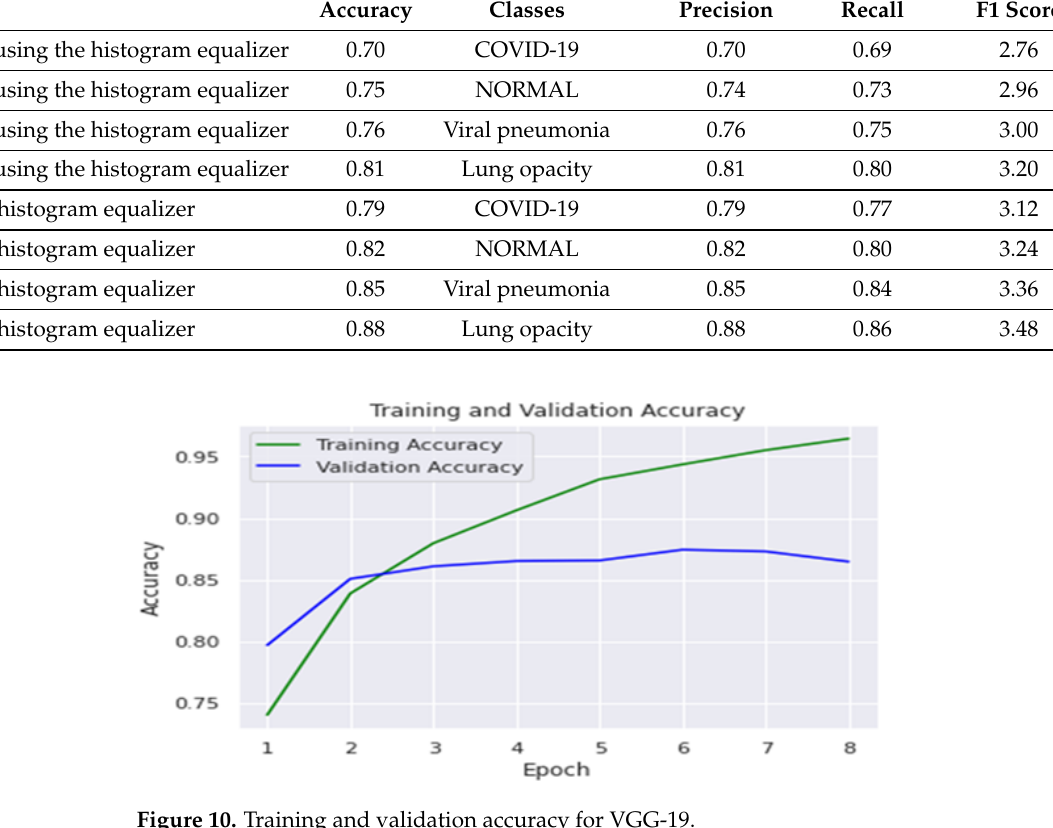
Figure 10. Training and validation accuracy for